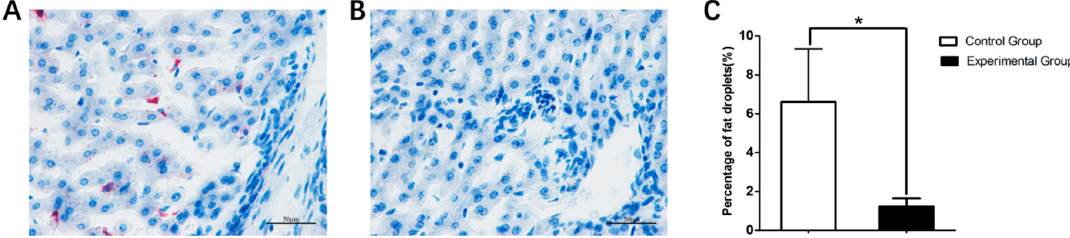
Figure 5. Fasting caecotrophy decreased liver lipid droplet accumulation. Lipid droplets were stained with Oil red O ( A : control group; B : experimental group. Scale bar = 50 µm; C : % area covered with Oil red O staining as measured by using Image-Pro Plus 6.0). A and B are representative images of 3 biological replicates. Values are presented as means ± SD. *, p < 0.05.